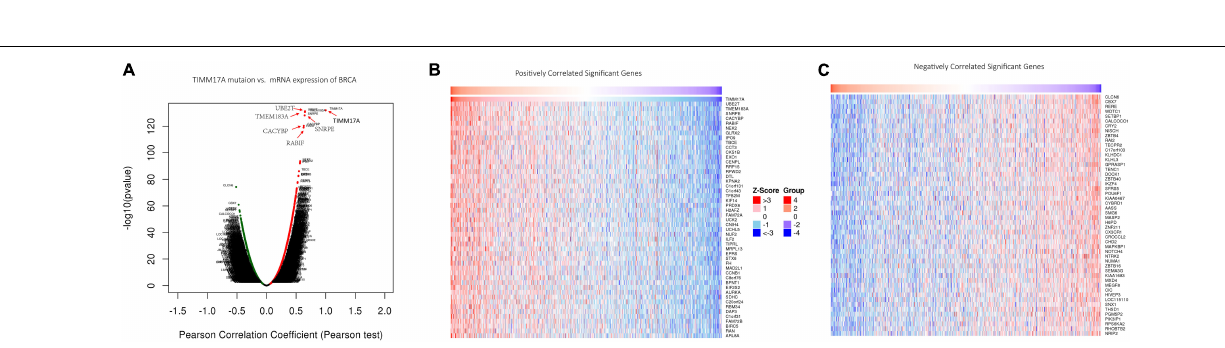
Frontiers in Genetics |